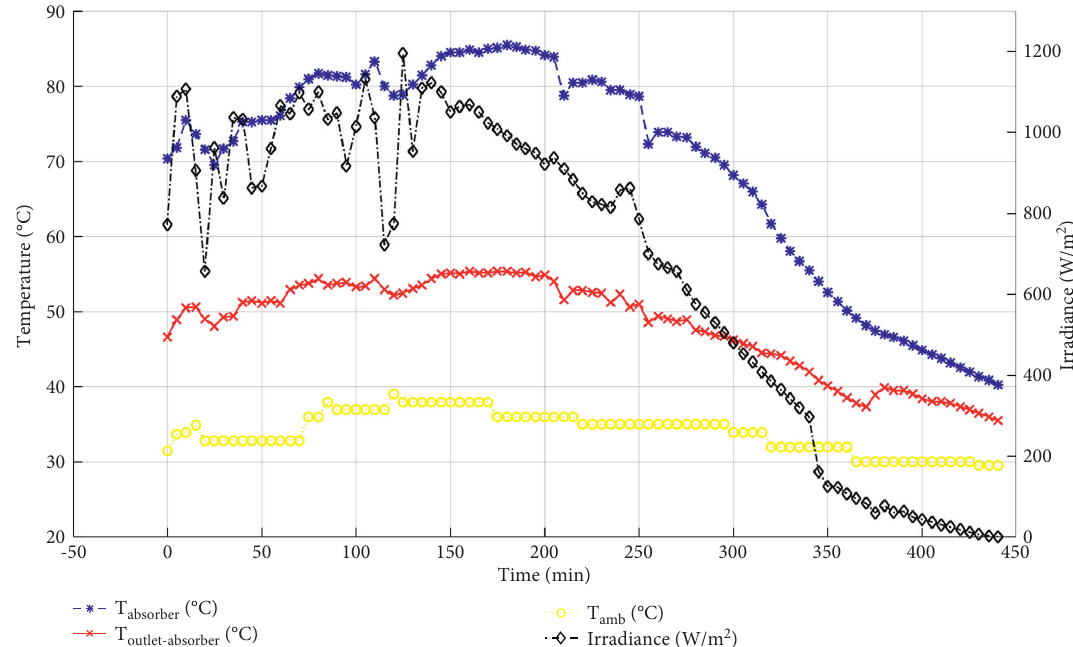
Figure 8: Temperature and irradiance profiles in dryer without regulation.